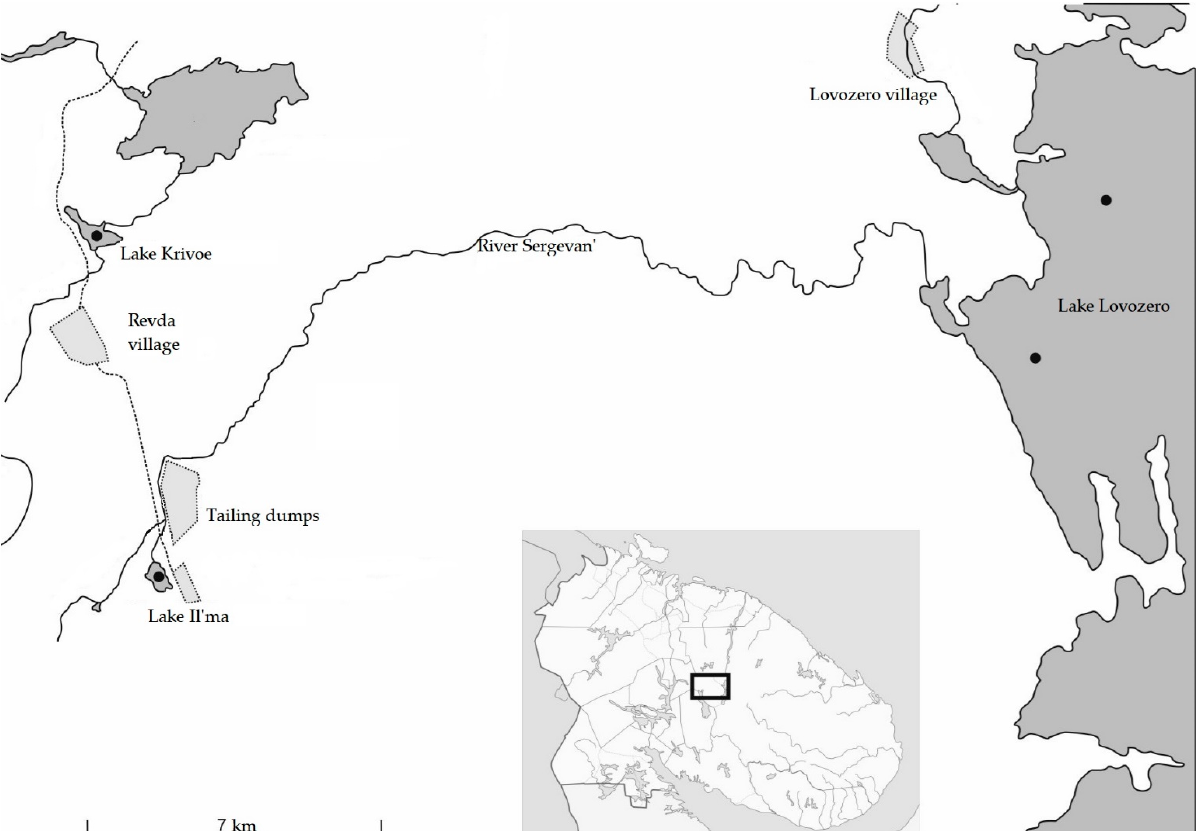
Figure 1. Sampling map—scheme of surface waters and BS of lakes.